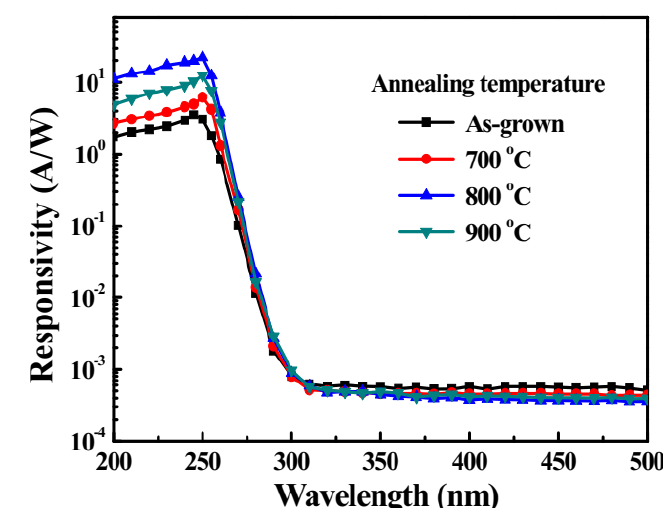
Figure 7. Photoresponsivity spectra of various Ga 2 O 3 -based MSM